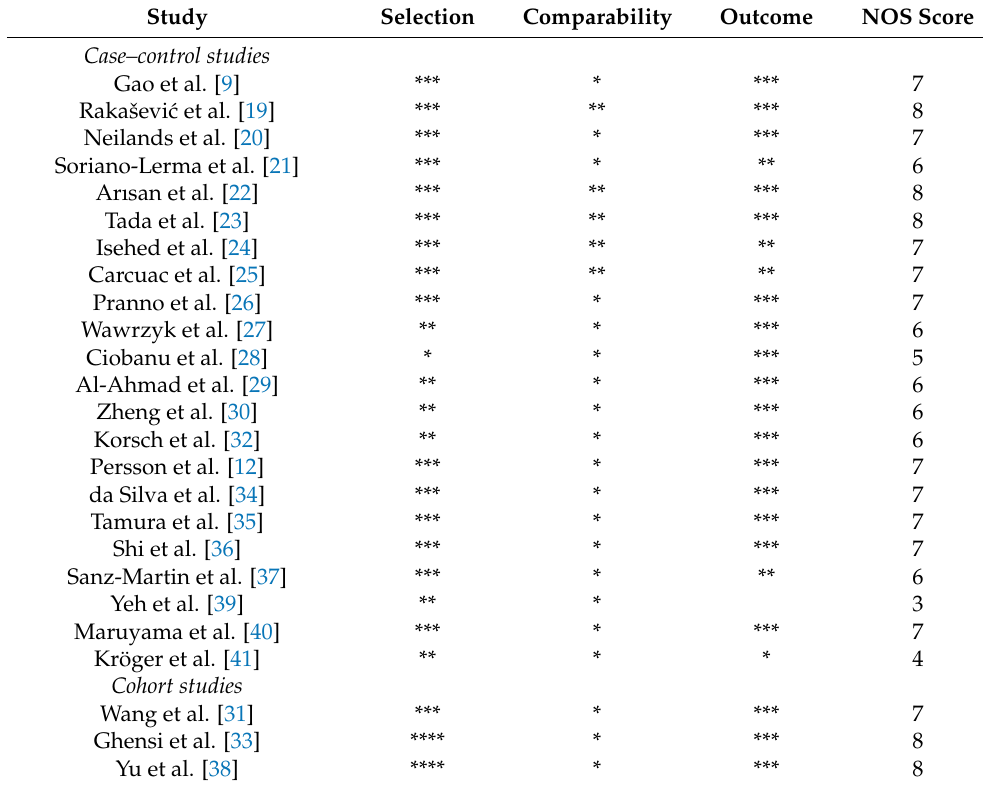
Table 2. NOS scores for the included